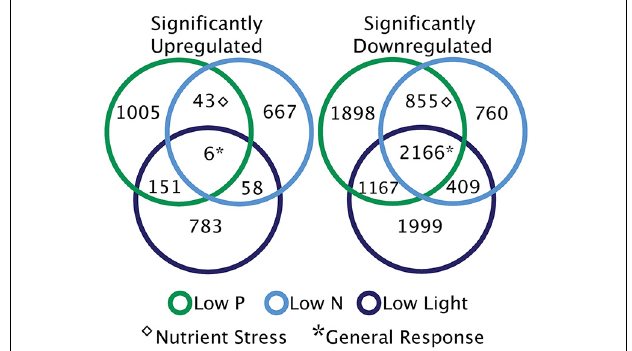
FIGURE 5 | Broad categories of significant transcriptional responses. Diagrams illustrate the patterns of significantly differentially regulated genes across the treatments. Sections without overlap represent unique responses to each treatment. Overlapping sections are indicative of nutrient stress response transcripts [overlap between low nitrogen (N) and low phosphorus (P)], and shared low light and low N or P responses. The generally responsive category describes significantly up or downregulated transcripts shared across three